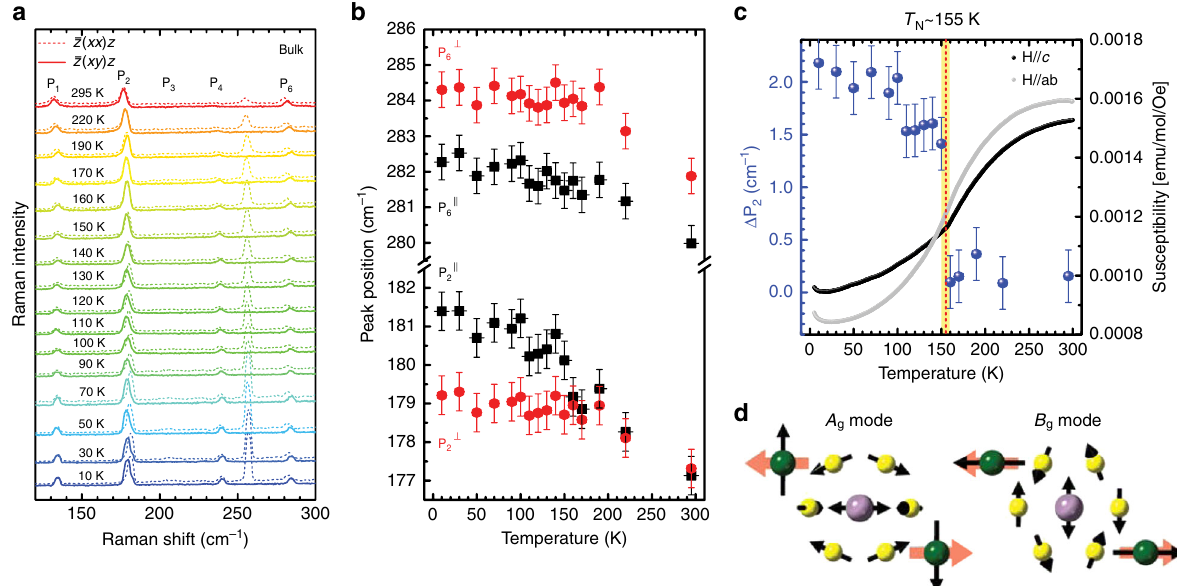
Fig. 4 Magnetic-order-induced frequency difference for phonon P 2 . a Polarized Raman spectra of bulk NiPS 3 as a function of the temperature. b Peak positions of P 2 and P 6 obtained in parallel (black squares, P jj temperature. c Temperature dependences of phonon frequency difference Δ P 2 ( Δ P 2 (cid:4) P jj bars indicate experimental uncertainties. d Schematics of lattice-vibration patterns associated with A g and B g modes near ~180 cm – 1 . Black arrows indicate the direction of atomic displacement and thick red arrows indicate spin orientations of Ni atoms below T N